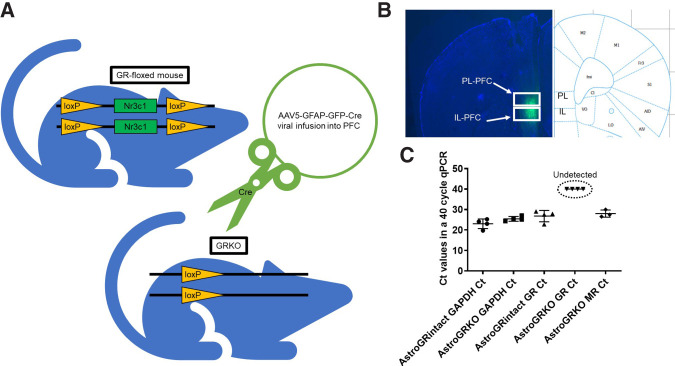
CRE-mediated knockout of GRs in astrocytes in the PFC. (A) AAV5-GFAP-GFP-Cre virus was injected into the PFC of GR-floxed mice to induce Cre recombinase-mediated knockout of the nr3c1 gene in astrocytes in the PFC. (B) Representative image of PFC injections spanning both the prelimbic (PL) and infralimbic (IL) subdivisions of the PFC (Allen Mouse Brain Atlas). (C) Astrocytes were isolated using FACS and qPCR was performed to determine nr3c1 gene expression in astrocytes. Transcripts of gapdh were detected in both AstroGRKO animals (Ct = 25.40 ± 0.5903) and AstroGRIntact animals (Ct = 23.0 ± 1.184). Ct values for gapdh did not differ significantly between the groups (P > 0.05). nr3c1 transcripts were detected only in AstroGRintact animals (Ct = 26.77 ± 1.386). nr3c1 transcripts were not detected in AstroGRKO animals, not reaching fluorescent threshold in 40 cycles. nr3c2 transcripts were detected in AstroGRintact animals (n = 3–4/group, ANOVA: F(3,12) = 63.44, P < 0.0001; post-hoc comparisons: AstroGRIntact GAPDH Ct vs. AstroGRKO GAPDH Ct, P > 0.05, AstroGRIntact GR Ct vs. AstroGRKO GR Ct
P < 0.0001). (nr3c1) Gene encoding GR, (nr3c2) gene encoding mineralocorticoid receptor.